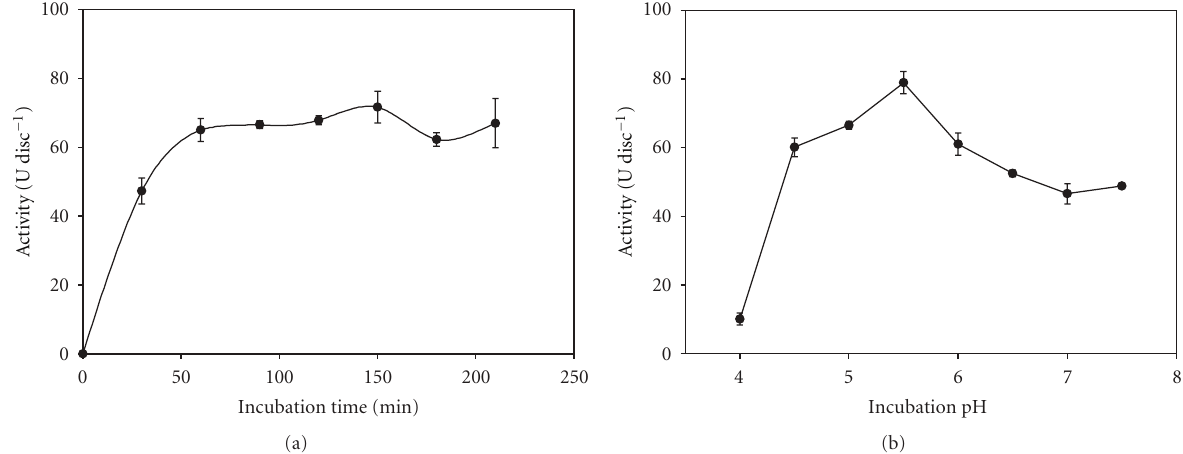
Figure 3: Optima time (a) and pH (b) for the immobilization of the soluble HRP on the PVAG-PANIG.